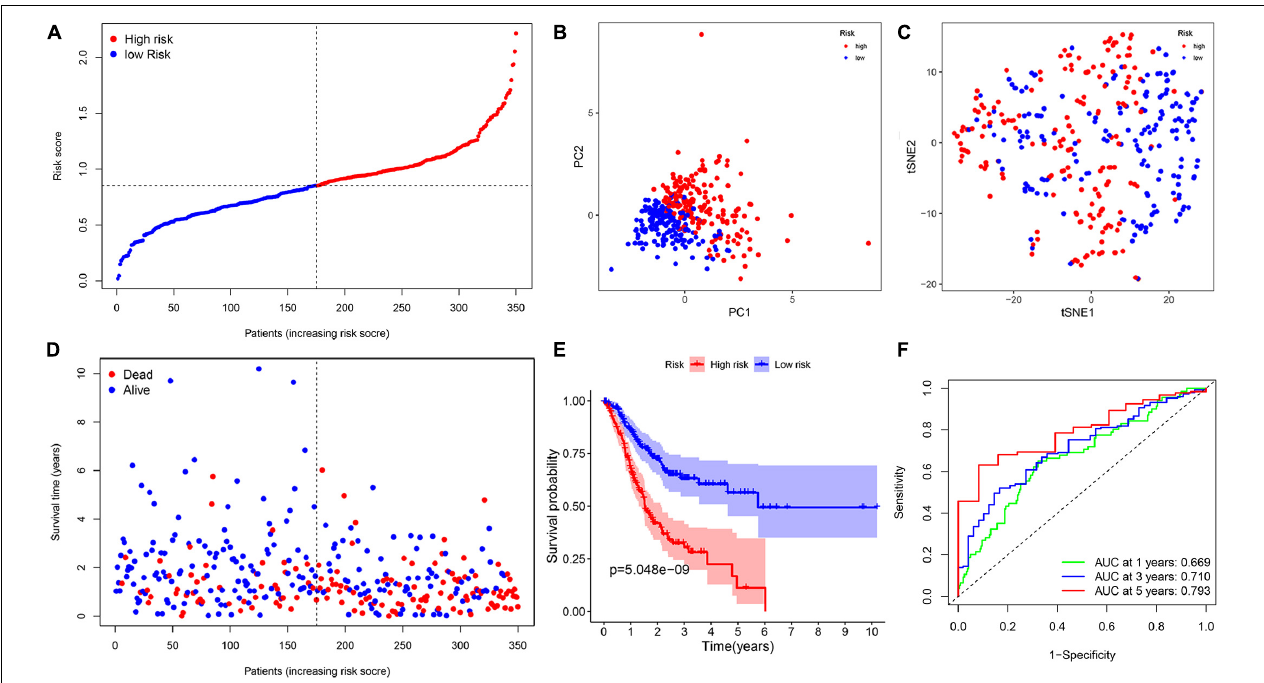
FIGURE 6 | The construction of risk signature in the TCGA cohort. (A) The distribution of risk score. (B) Principal component analysis (PCA) analysis. (C) T-distributed stochastic neighbor embedding (T-SNE) plot. (D) The distribution of OS. (E) The Kaplan–Meier survival analysis of OS between two groups. (F) Area under the curve (AUC) in receiver operating characteristic (ROC) analysis for risk signature at 1-, 3-, and 5-year survival